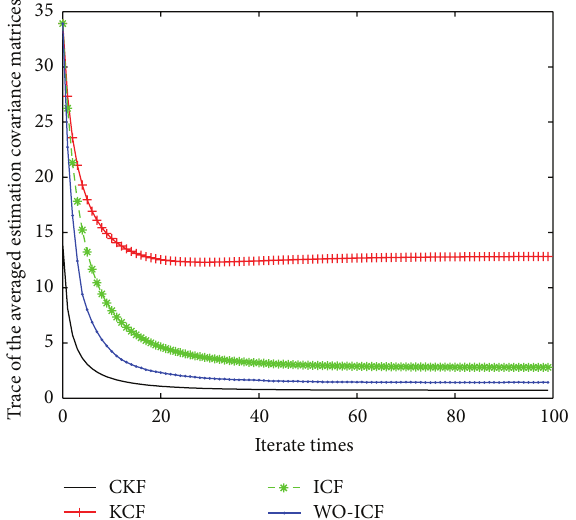
Figure 5: The traces of the averaged estimation covariance matrices of different